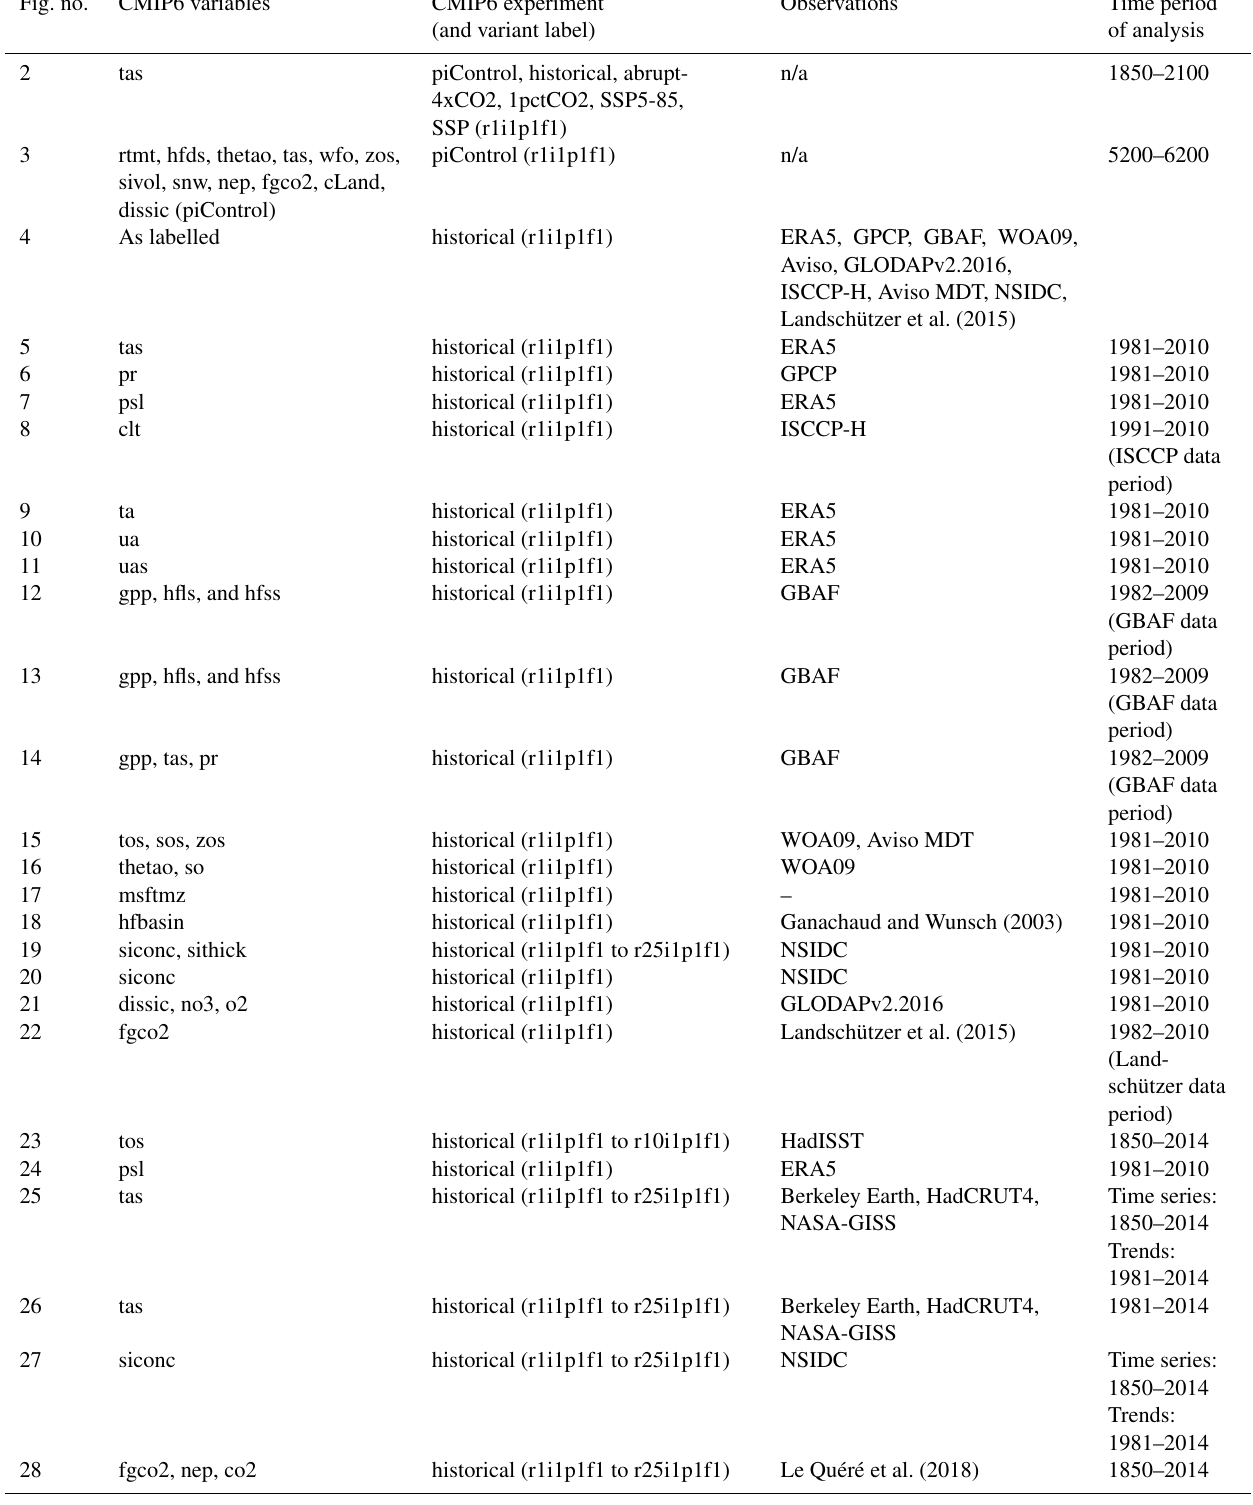
Table F1. List of figures, CanESM5 CMIP6 variables, and observations used, and the time periods of analysis in the main text. See Table F3 for a definition of variable names. “n/a” indicates “not